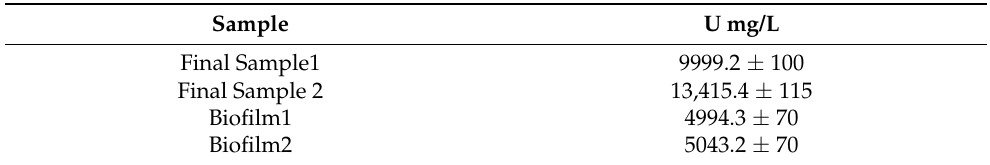
Table 4. Determination of uranium. TFRX results: Final samples: precipitated biomass and biofilms; samples from bacteria adhering on